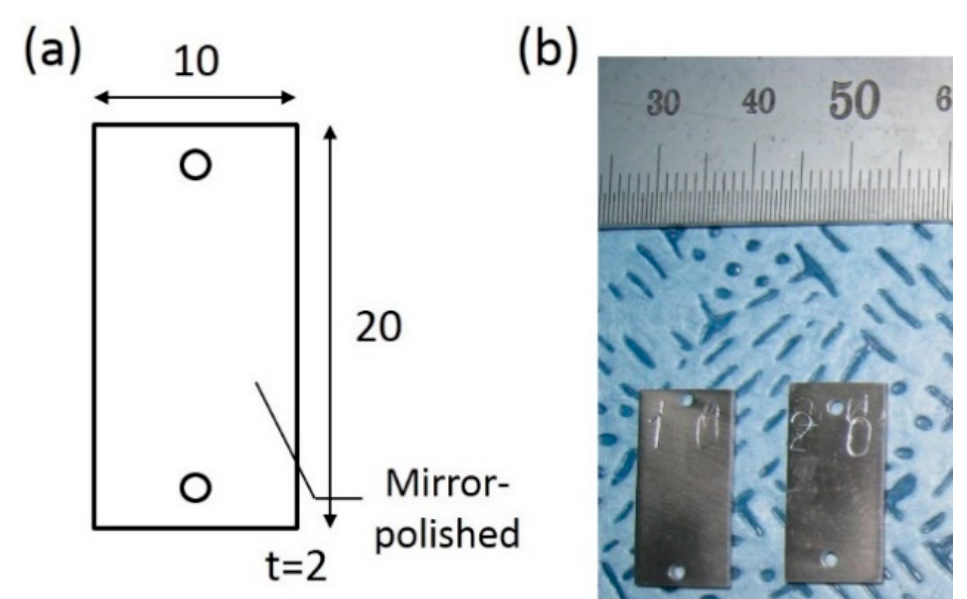
Figure 2. ( a ) Schematic diagram and ( b ) picture of a corrosion specimen. Table 2. Heat treatment and etching conditions of tested